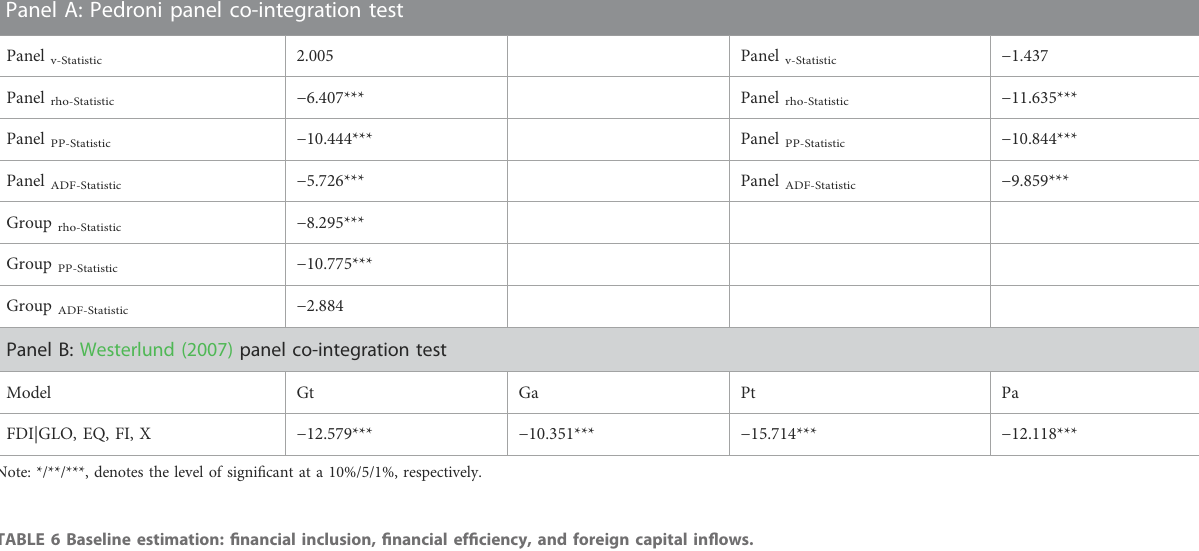
TABLE 5 Panel co-integration test.